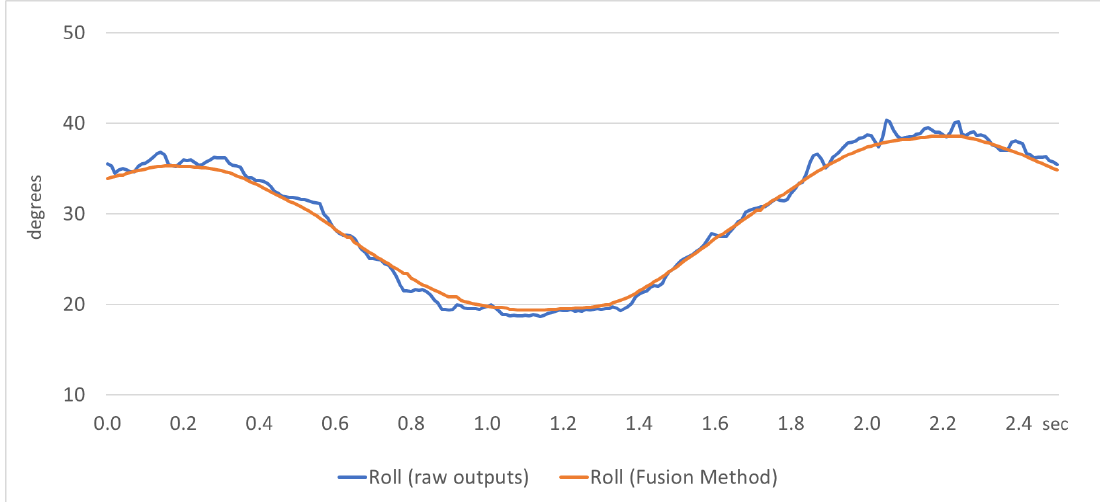
Figure 8. Roll angle estimation by raw outputs and the fusion method in kinematic condition.